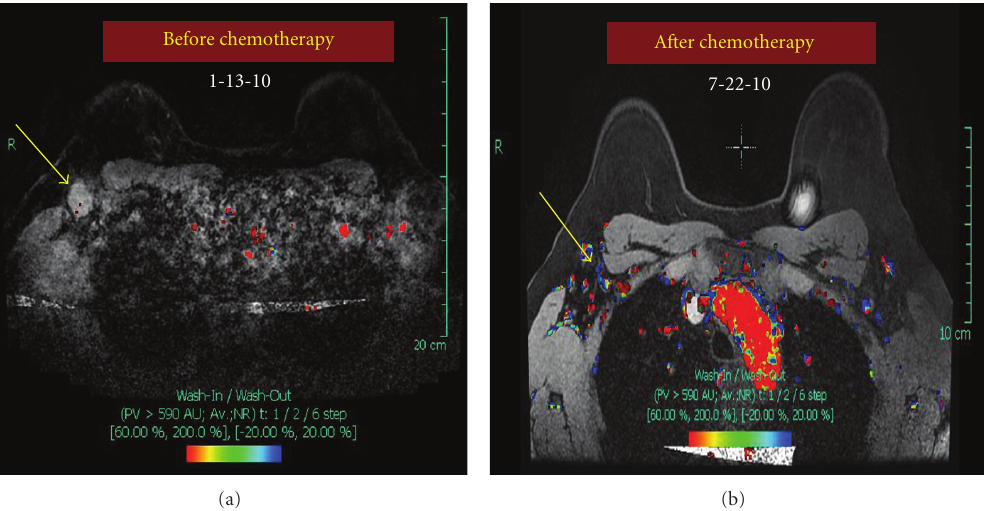
Figure 4: Comparison of bilateral MRI of the right axilla performed before and after neoadjuvant chemotherapy. (a) Doppler flow MRI before neoadjuvant chemotherapy. Yellow arrow points to a 2.6 cm pathologically enlarged right axillary lymph node. (b) Doppler flow MRI after neoadjuvant chemotherapy shows complete radiologic response. The yellow arrow points to the normal-appearing right axillary lymph node.